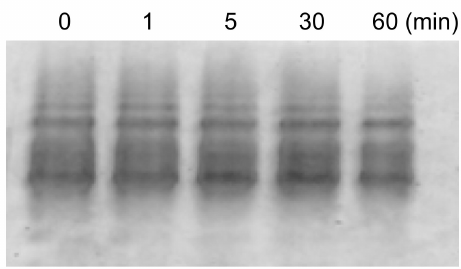
Figure 4. Native-PAGE of (Cu,E)-H43R in phosphate buffer after the indicated incubation times at 37 ◦